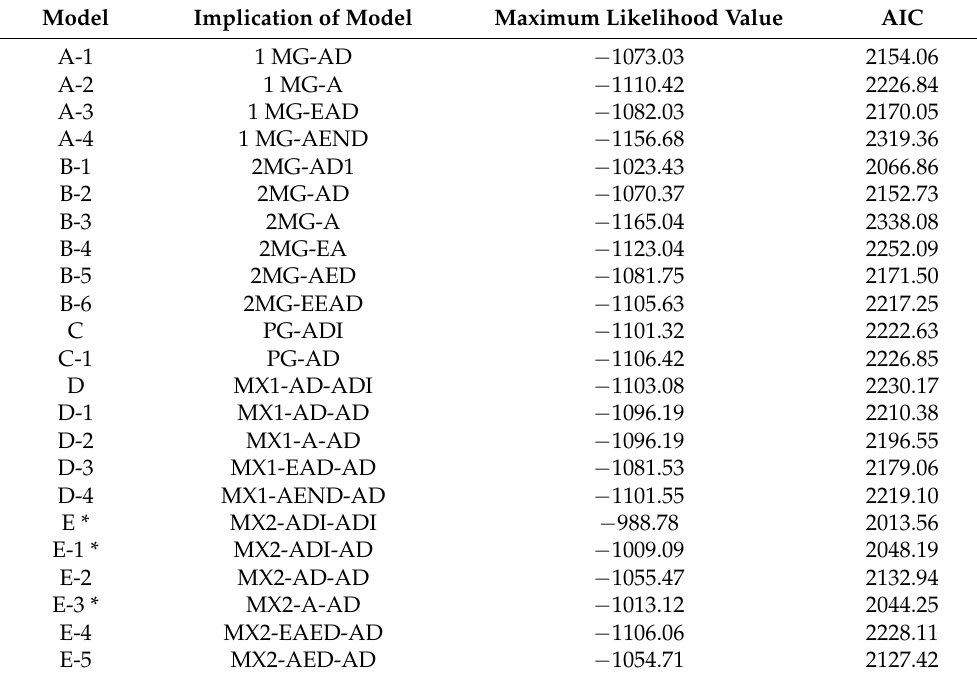
Table 3. The estimation of the maximum likelihood values and AIC values of the genetic model.